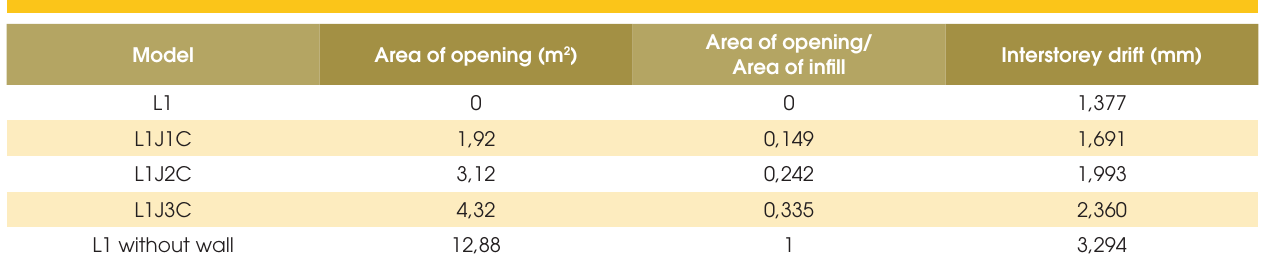
Table 6 – Influence of the area of opening on lateral stiffness of the models